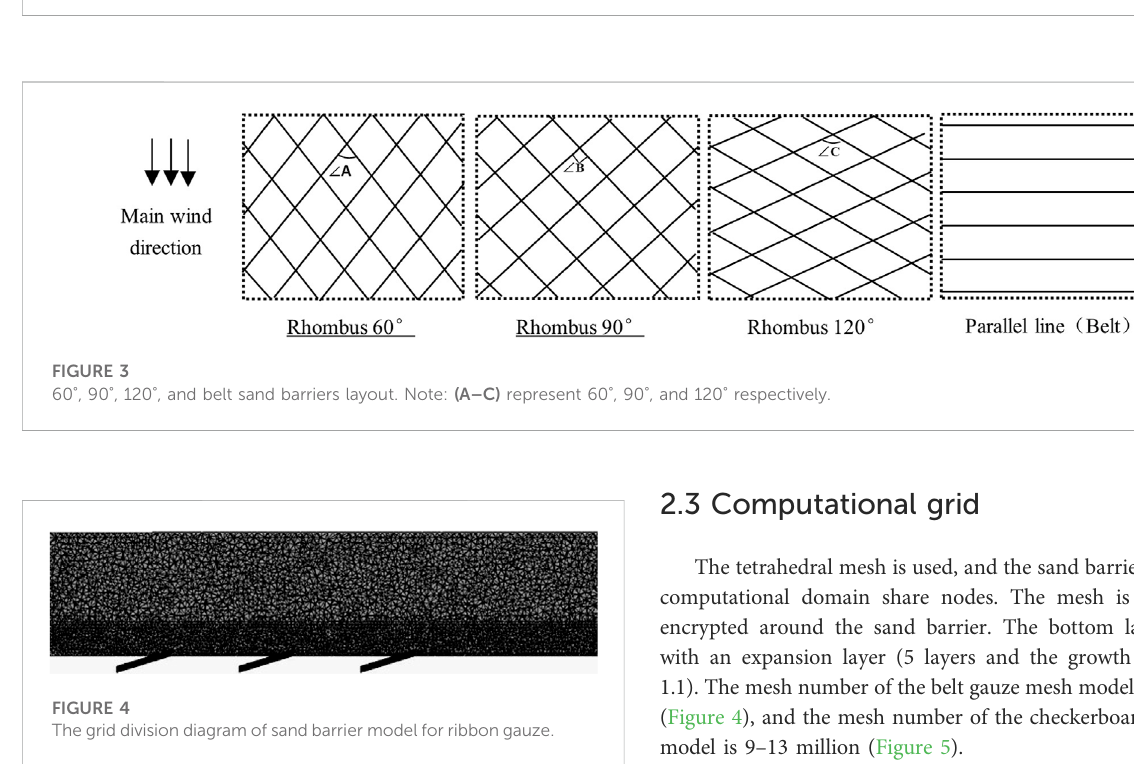
FIGURE 2 Model diagram of square sand barrier and its calculation area.